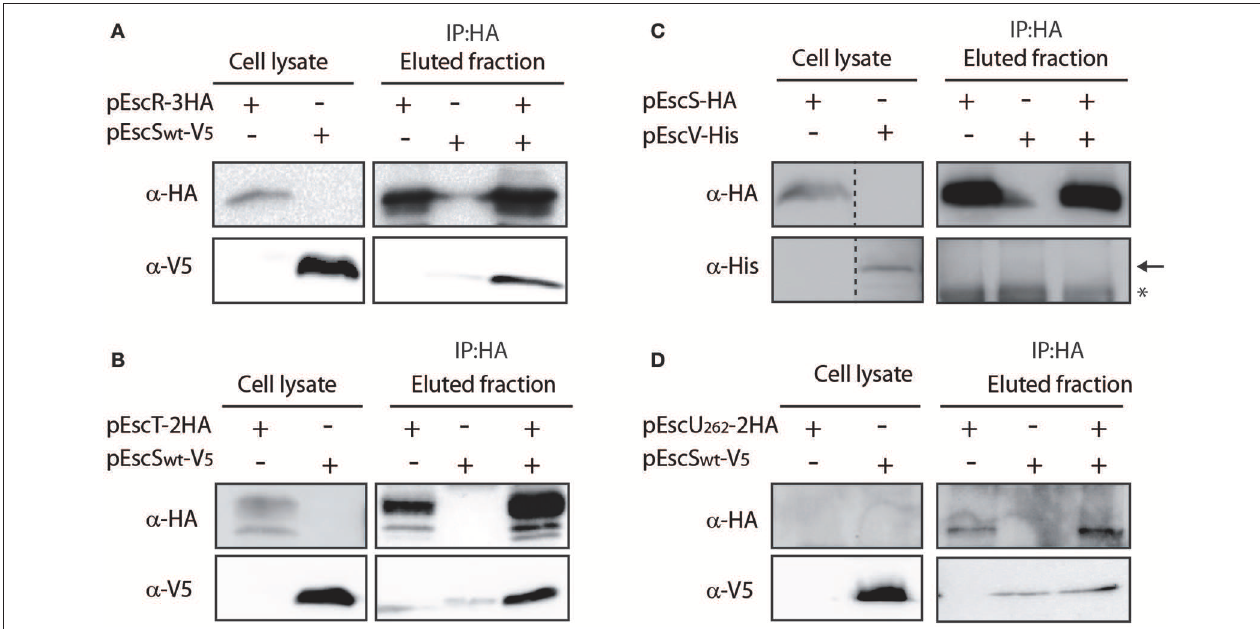
FIGURE 4 | EscS interacts with additional T3SS export apparatus proteins. (A) Whole-cell lysates of E. coli expressing either EscR-3HA or EscS wt -V 5 , were subjected to immunoprecipitation using protein G beads linked to an anti-HA antibody. The lysates were incubated alone or mixed. Samples of whole-cell lysates and elution fractions were loaded on an SDS-PAGE and analyzed by western blotting with anti-HA and anti-V 5 antibodies. Whole-cell lysates confirmed proper protein expression. EscS-V 5 co-eluted with EscR, in-vitro . (B–D) EscT-EscS (B) , EscS-EscV (C) , and EscU N262A -EscS (D) immuneprecipitations were examined as in panel A. EscS wt -V 5 co-eluted with EscT-2HA but no interactions were observed between EscS wt -HA and EscV-His or between EscS-V 5 and EscU N262A -2HA. In panel C, a black arrow represents the expected size of EscV-His and a star indicates an unspecific